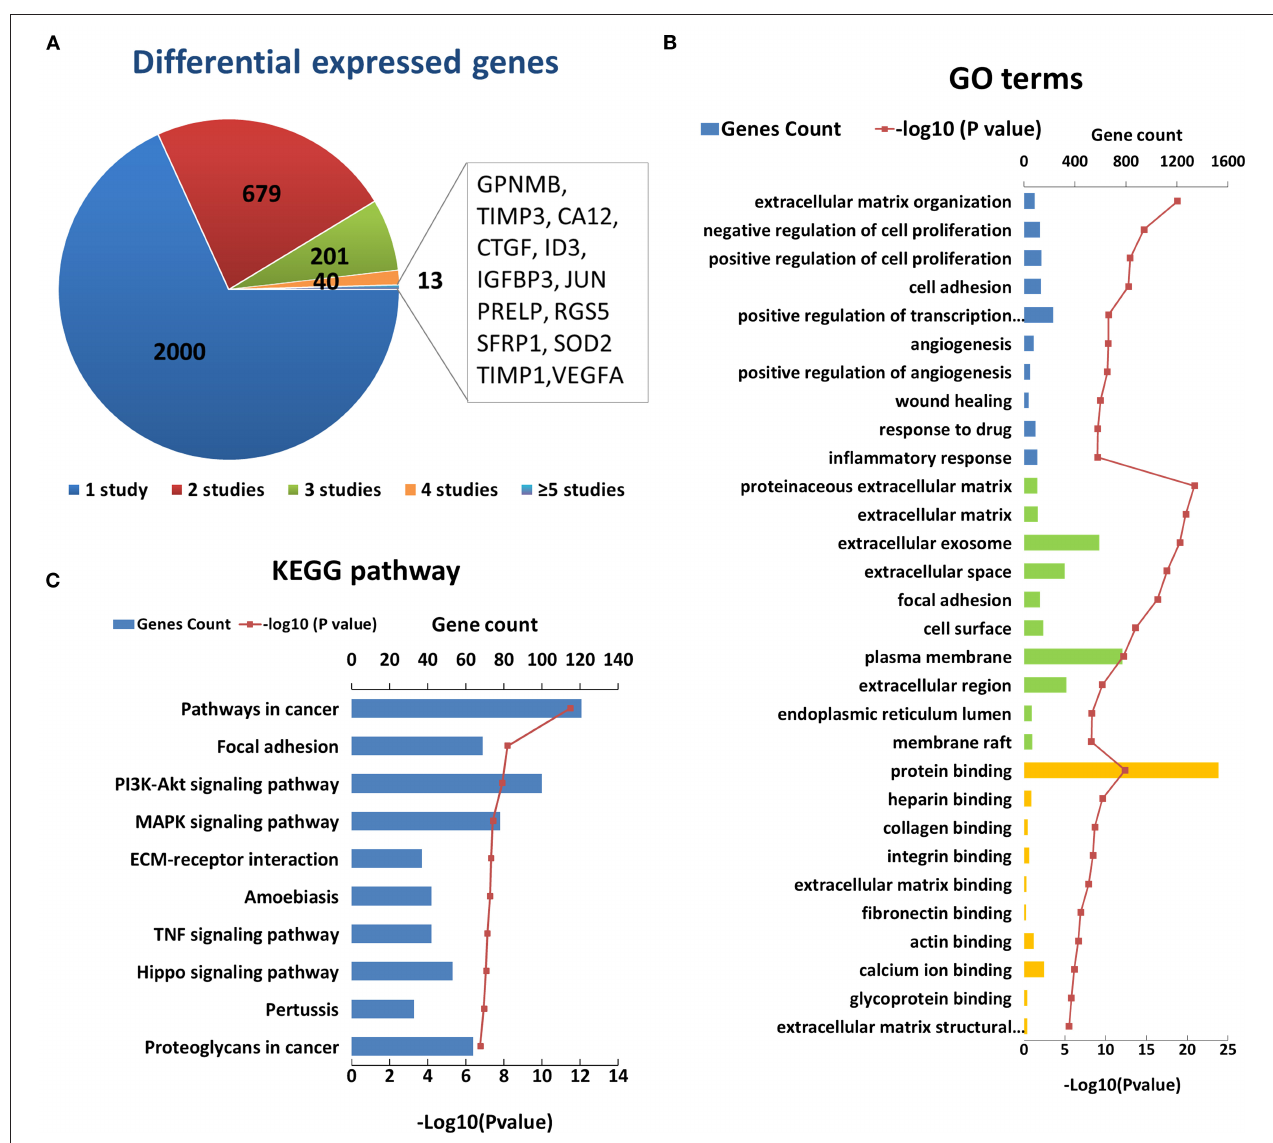
FIGURE 2 | Enriched GO terms and KEGG pathways based on 2933 differential genes at the transcription level. (A) The classification of the 2933 differential genes according to the number and results of related studies. (B) Top 10 enriched terms of each GO category at the transcription level. The three colors represent biological process (blue), cell component (green), and molecular function (yellow), respectively. (C) Top ten enriched KEGG pathways at the transcription